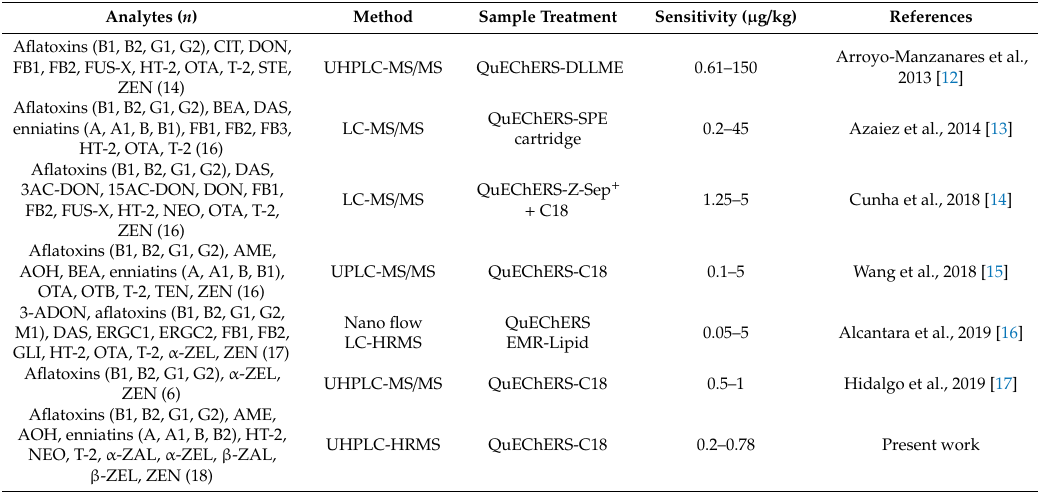
Table 2. Quantitative methods for multi-mycotoxin detection in several tree nut